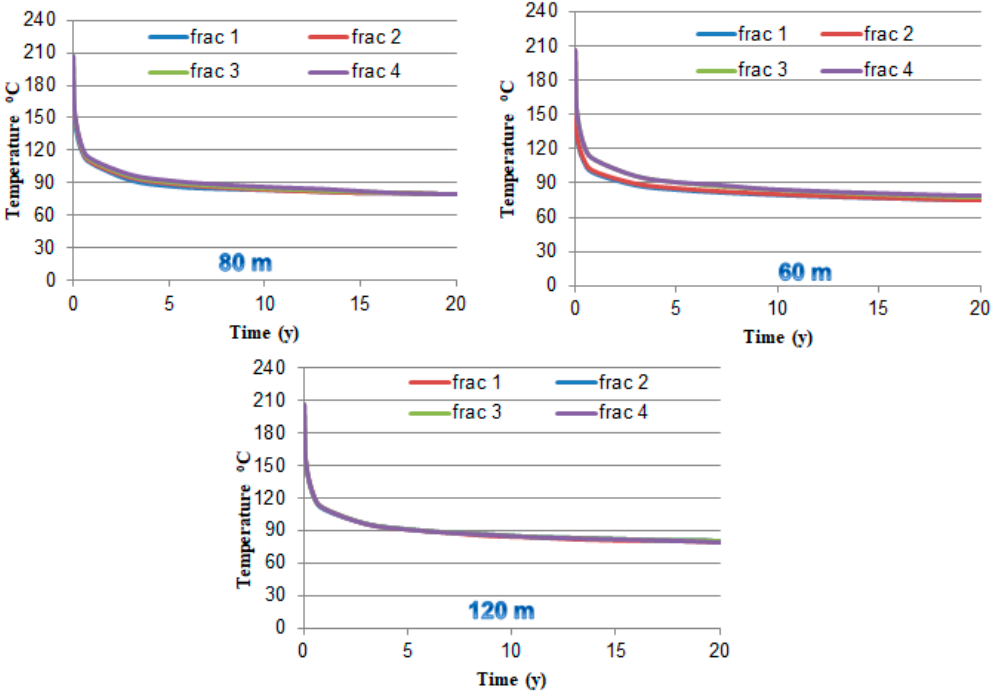
Figure 8. Temperature decline trends within 20 years of time period in four fracture with 60, 80, and 120 m fracture spacing.